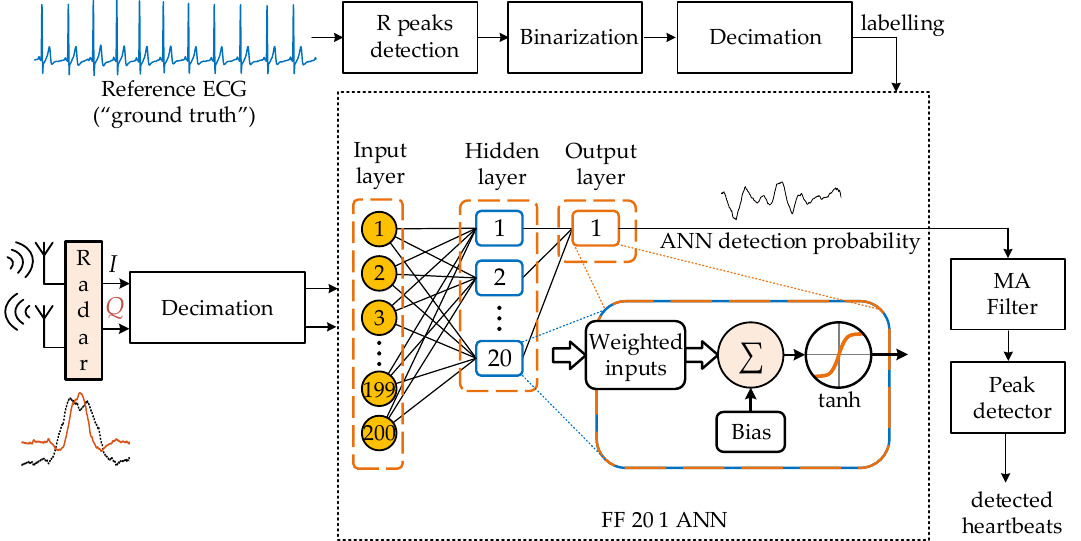
Figure 5. Flowchart for the proposed method for heartbeat detection based on the classical shallow feed-forward neural network with a single hidden layer with 20 neurons (FF 20 1 ANN). The artificial neural network (ANN) input is the 200-sample long vector containing resampled 100 in-phase and 100 quadrature component samples. For the FF 20 1 ANN there are 20 neurons in the single hidden layer and 1 neuron in the output layer. MA Filter — moving average filter.